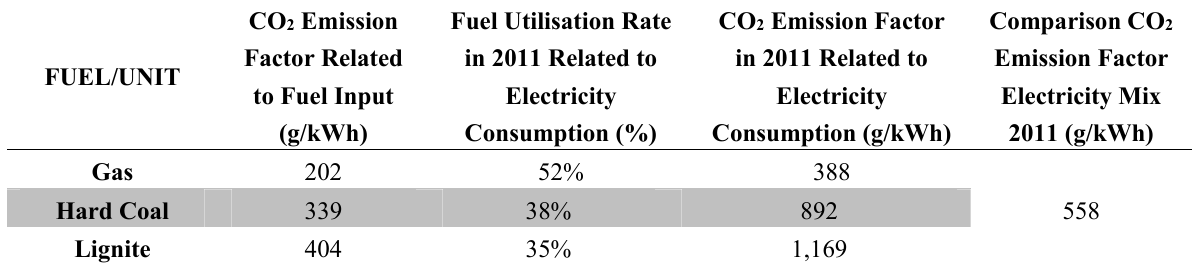
Table 3. Fossil fuel CO 2 emission factor in the German electricity mix